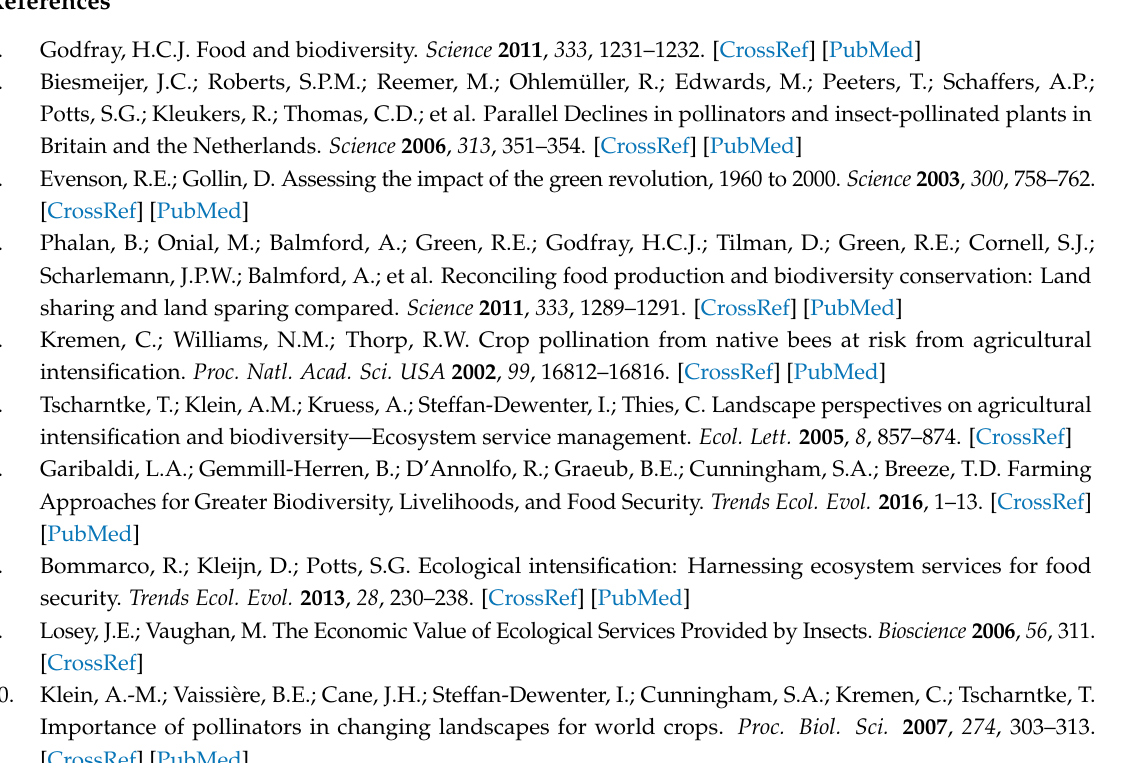
Figure S1: Experimental plot design. Grey lines represent tree rows (fifteen trees per plot), Table S1: Plant species composition, (H) Habit (P—Perennial, A—Annual or B—Biennial), Trait group (CNP = concealed nectar, ONP = open nectar), percentage contribution (by weight) in each treatment (MF = Multi-functional) and literature source, Table S2: Floral unit classification (FH = flower head), median flower number per unit, median flower width (mm) and floral area (mm) for all flowering species, Table S3: Insect visitor taxa and number of visits each year during observations ( n = No. of replicates per year) of experimental plots (con = control, cnp = concealed-nectar, mix = mixed treatment, onp = open-nectar). Visiting insect species are grouped into pollinators (POL), aphidophagous predators (APH) and generalist natural enemies (GEN), Table S4: Aphid colony densities and natural enemy taxa (abundance and richness) recorded in adjacent apple trees each year during tree surveys ( n = No. of repeat surveys) of experimental plots (con = control, cnp = concealed-nectar, mix = mixed treatment, onp = open-nectar). Insect taxa are grouped into crop pests (CP), aphidophagous predators (APH) and generalist natural enemies (GEN). See main text for details on collected life history